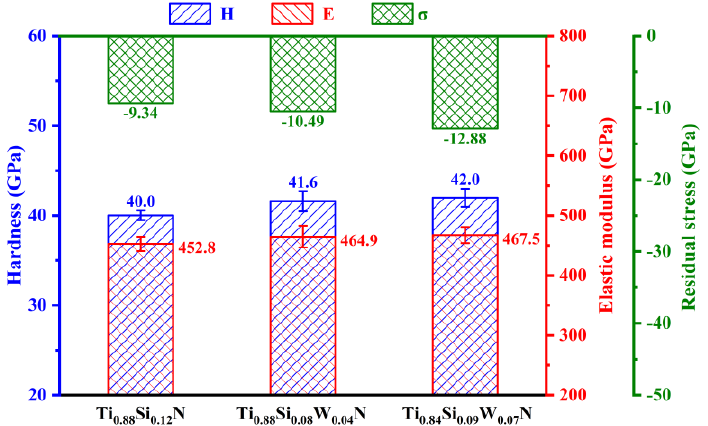
Figure 4. Hardness (H), elastic modulus (E), and residual stresses (σ) of as -deposited Ti 0.88 Si 0.12 N, Ti 0.88 Si 0.08 W 0.04 N, and Ti 0.84 Si 0.09 W 0.07 N